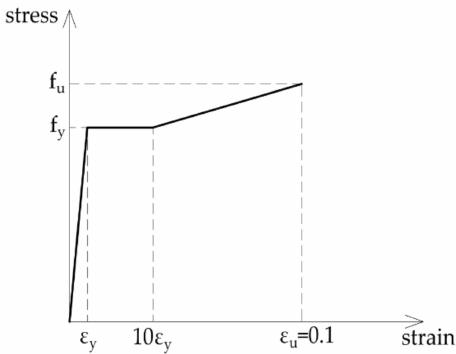
Figure 9. The constitutive model for structural steel.